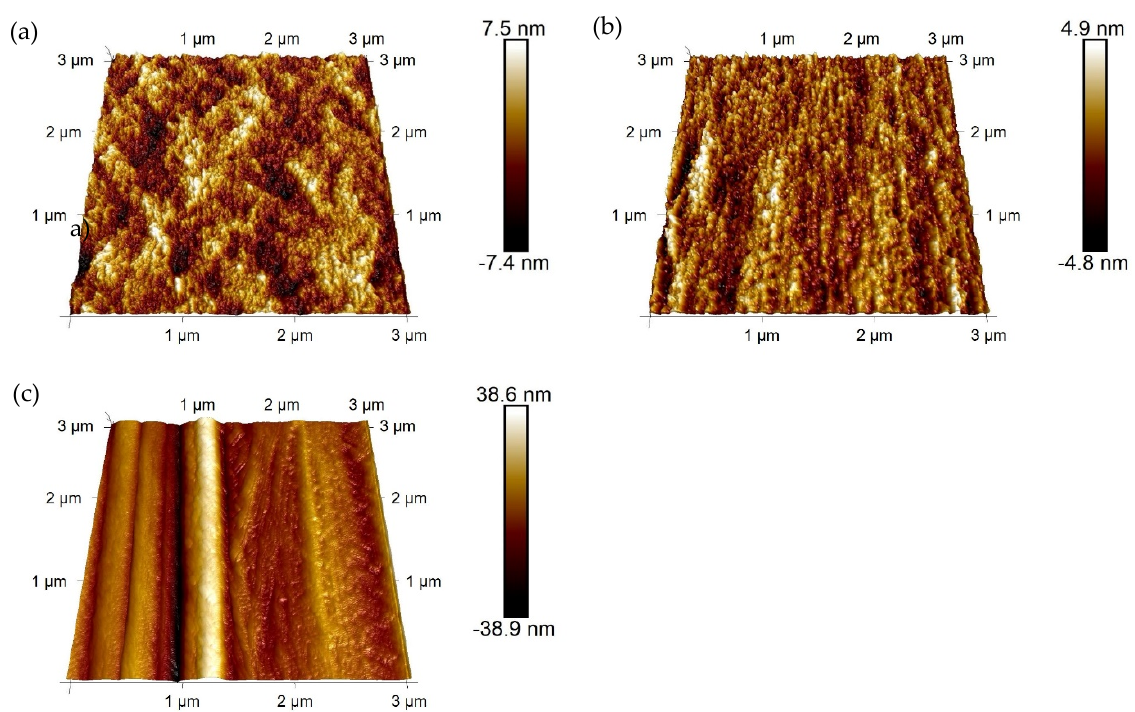
Figure 5. Height images of ( a ) C20 − , ( b ) C20 and ( c ) C20+ PP fibers determined by atomic force microscopy (AFM) (tapping mode). Table 4. Average roughness R a and maximum roughness R max values of PP fiber surfaces with increasing drawing ratio determined by AFM.